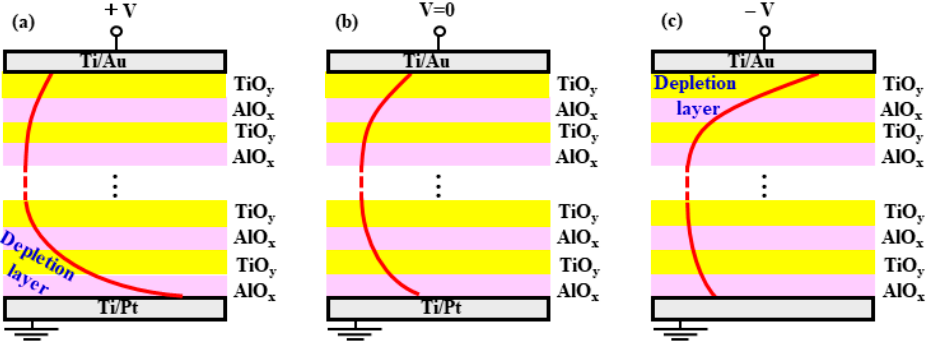
Figure 9. Schematic diagrams of the double-Schottky electrode contact model at a voltage of: ( a ) +V, ( b ) V = 0, and ( c ) − V, respectively.